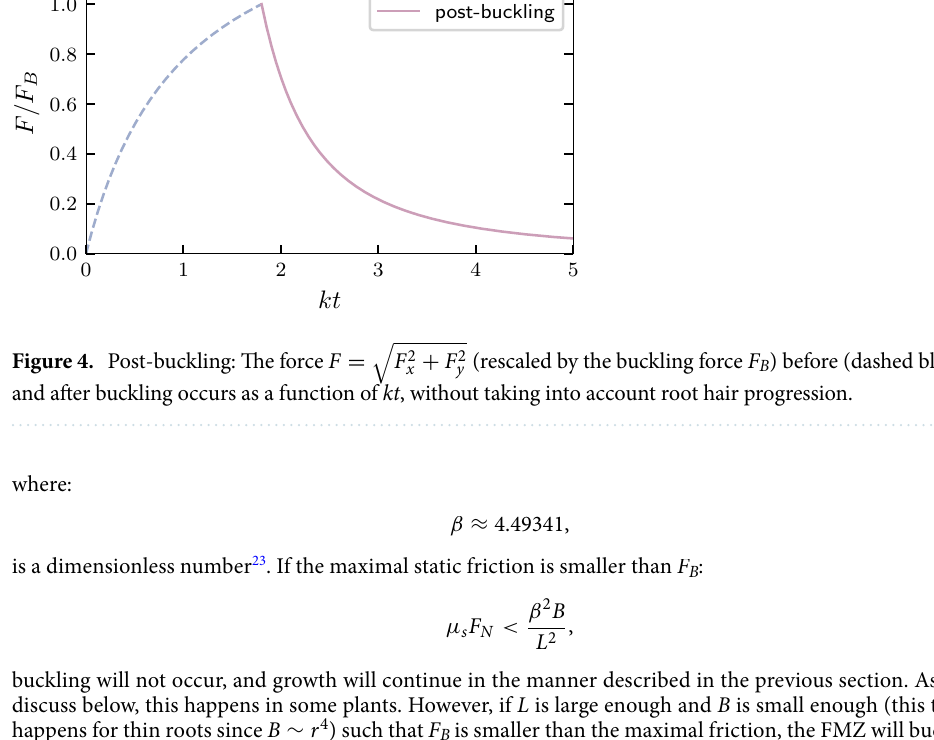
F B ) before (dashed blue line)